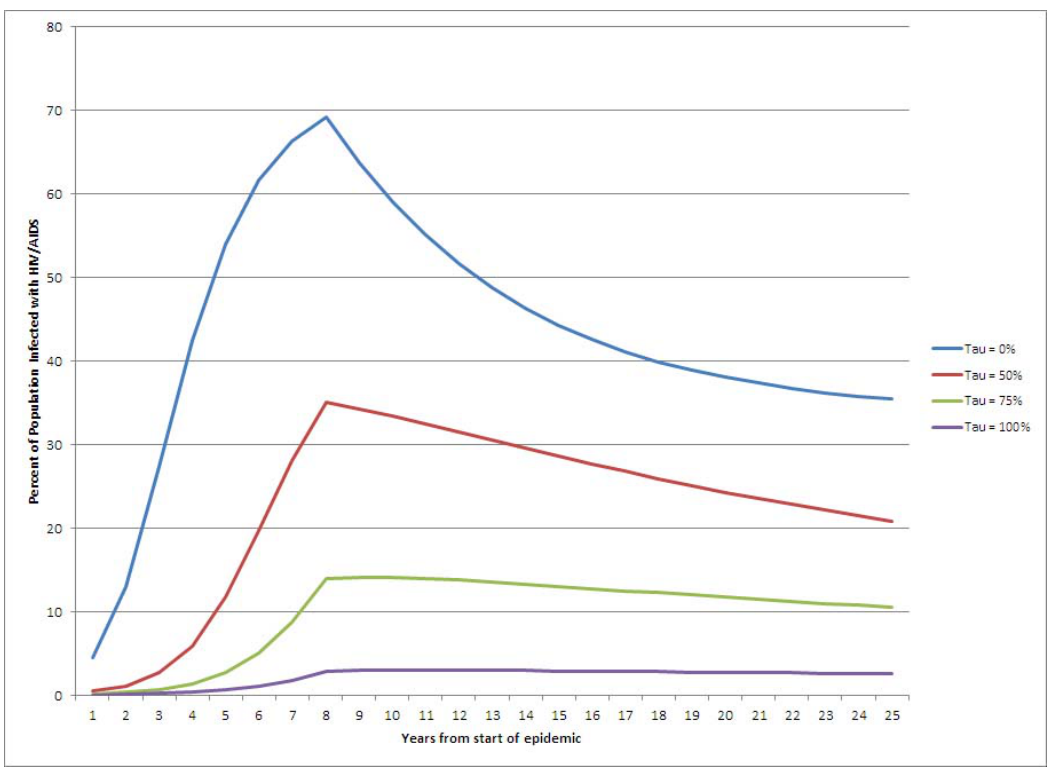
Figure 3. SFCCC epidemic with reduction in number of contacts by a factor of 10 after 7 years of the start of the epidemic and testing rate,